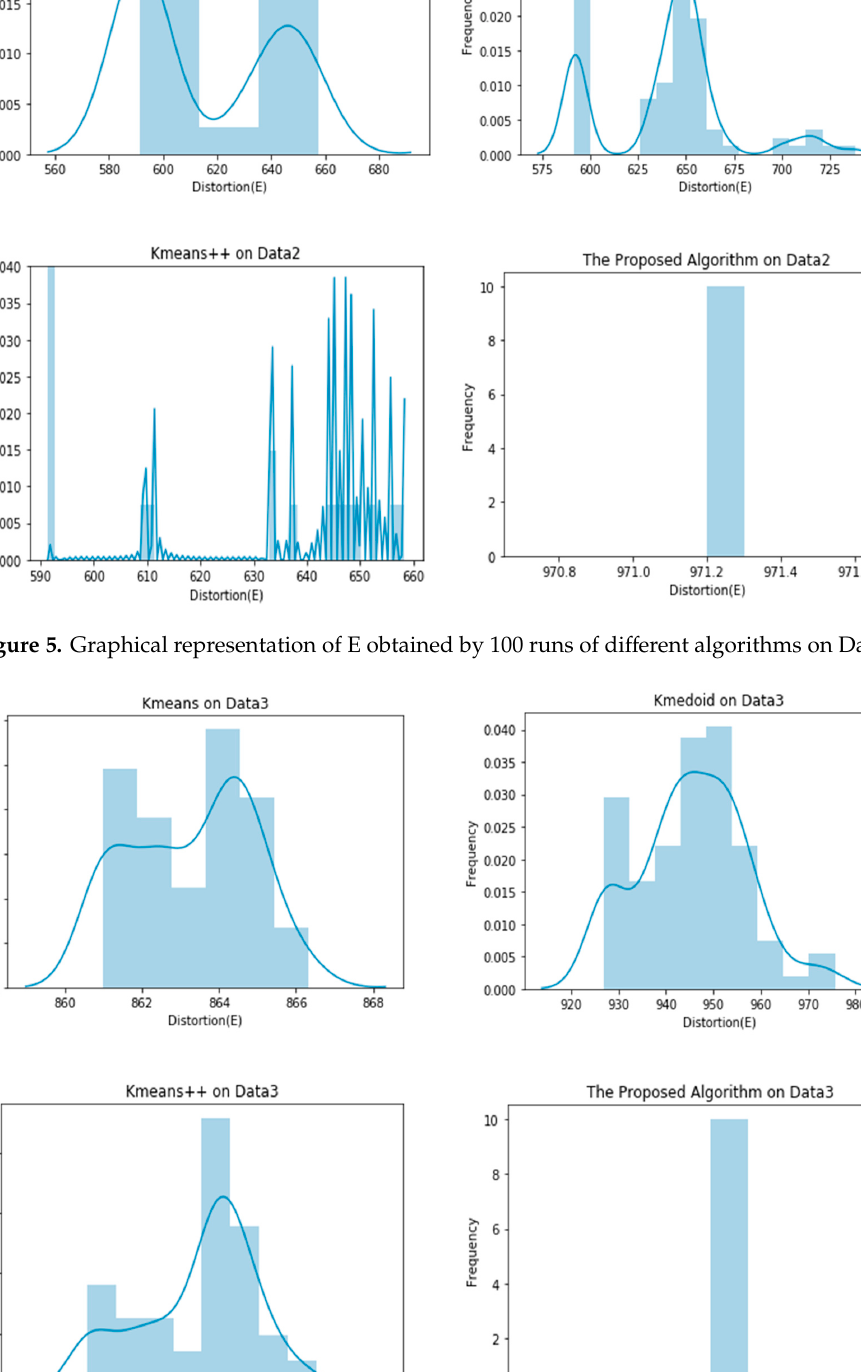
Figure 6. Graphical representation of E obtained by 100 runs of different algorithms on Data3.